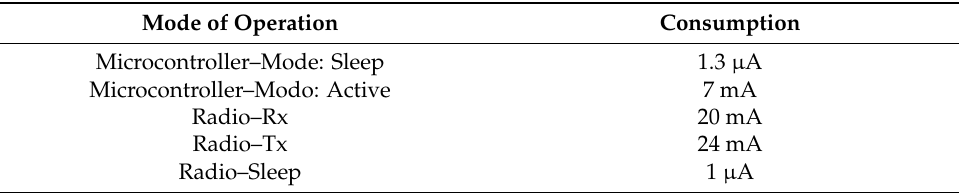
Table 4. Operation modes and Power consumption for OpenMote B.